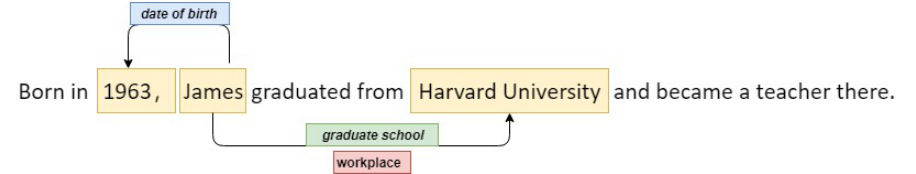
Figure 1. An example of entity–relation extraction. There are three triplets in the sentence, where < James, graduate school, Harvard University > and < James, workplace, Harvard University > have overlapping entity pairs, while both of them have a entity overlap with < James, date of birth, 1963 > . Secondly, most existing methods pay little attention to the e ff ect of sequence length on performance. Generally, self-attention is an e ff ective mechanism for assigning context words or characters with attention weights that define a weighted sum over context representations [16]. Attention weights are computed for all pairs of elements in the source sequence. One problem of self attention is that long sequence processing becomes very challenging because of the quadratic complexity in the sequence length. To solve this problem, researchers have proposed di ff erent kinds of attention mechanisms, including the local attention mechanism [17] and the hard attention mechanism [18]. Even though these methods improved the performance of attention mechanisms, they are either not flexible enough or require reinforcement learning for training due to their discrete